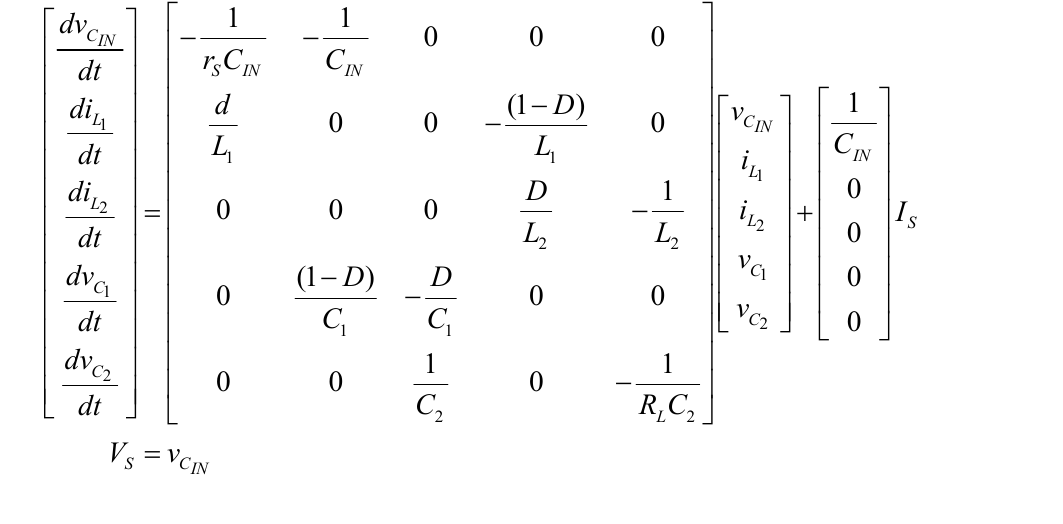
Figure 5. The current-fed Zeta buck-boost converter